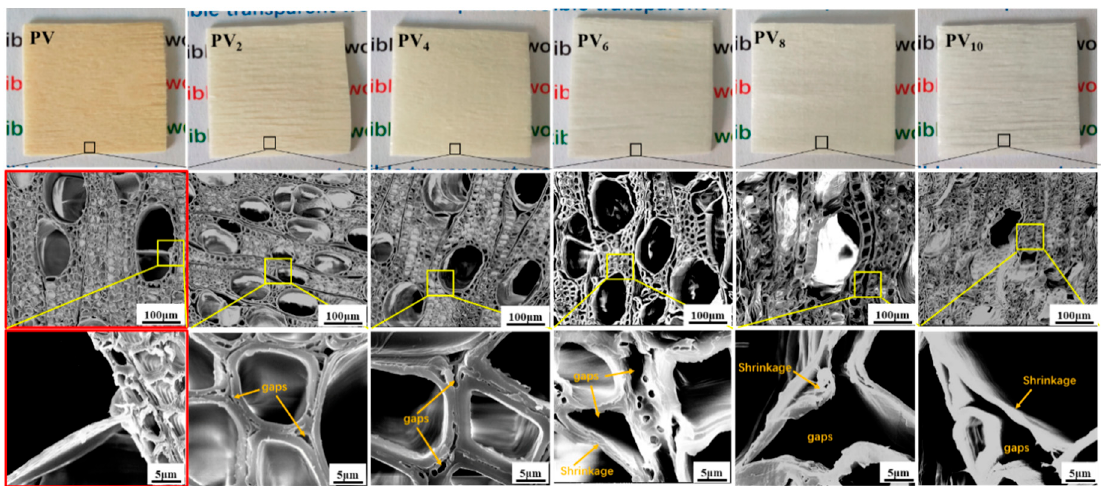
Figure 2. The physical objects and the microstructure of the cross-section of PV, PV 2 , PV 4 , PV 6 , PV 8 , and PV 10 under 300 and 5000 magnifications, respectively.